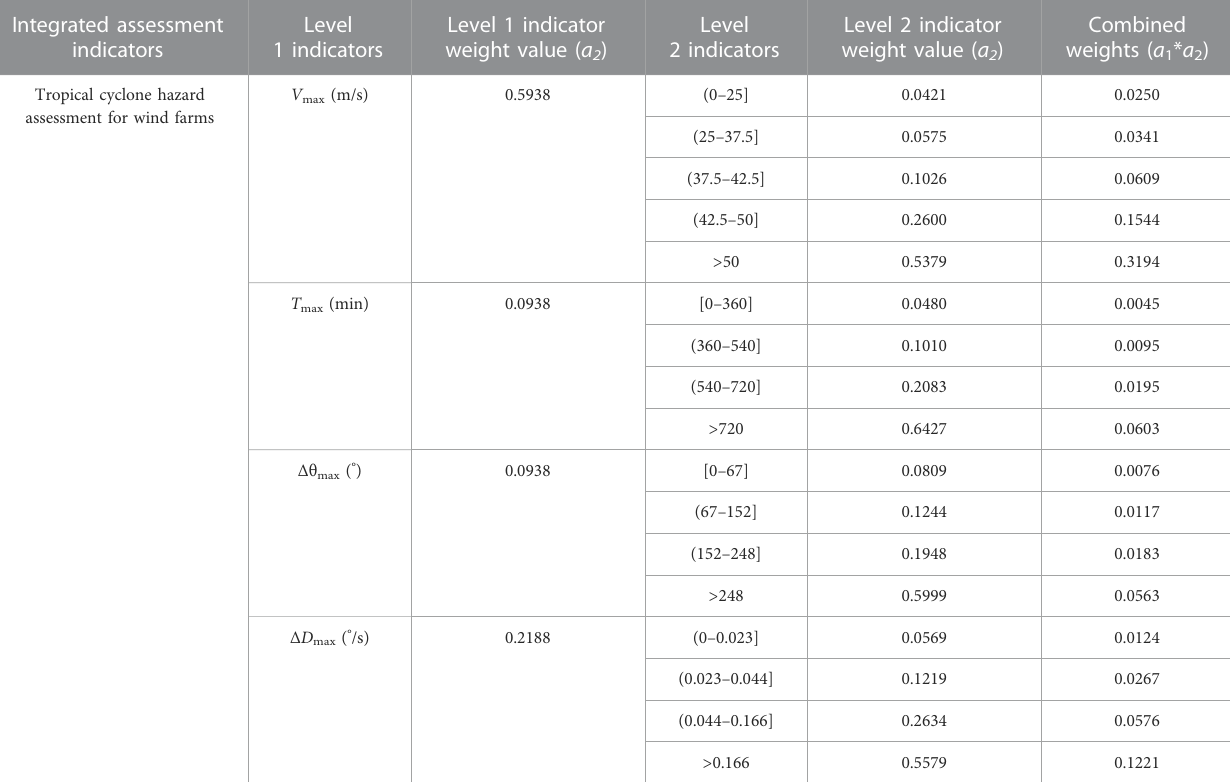
TABLE 6 Tropical cyclone hazard assessment indicators and their weighting values for the wind farm. Integrated assessment